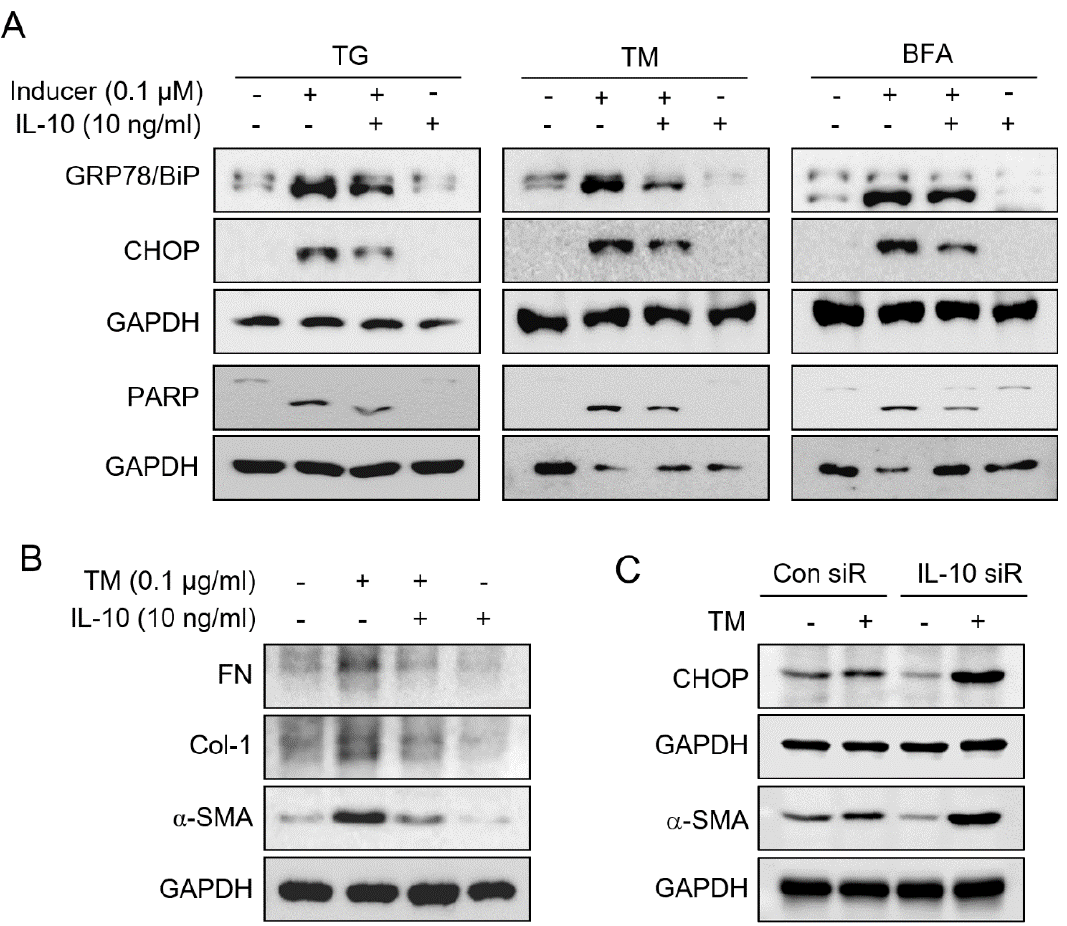
Figure 5. IL-10 impeded ER stress and fibrosis in tubular epithelial cells. BiP, CHOP, and PARP levels in ERS inducers (TG, TM and BFA) treated TCMK-1 cells with or without IL-10 pre-expose were determined by Western blotting ( A ). Fibrosis-related protein levels were also determined in TM treated TCMK-1 cells with or without IL-10 pre-expose ( B ). CHOP and α -SMA levels in TM treated TCMK-1 cells were determined by Western blotting after transfected with by IL-10 siRNA or Con siRNA ( C ). GAPDH was used as the loading control.